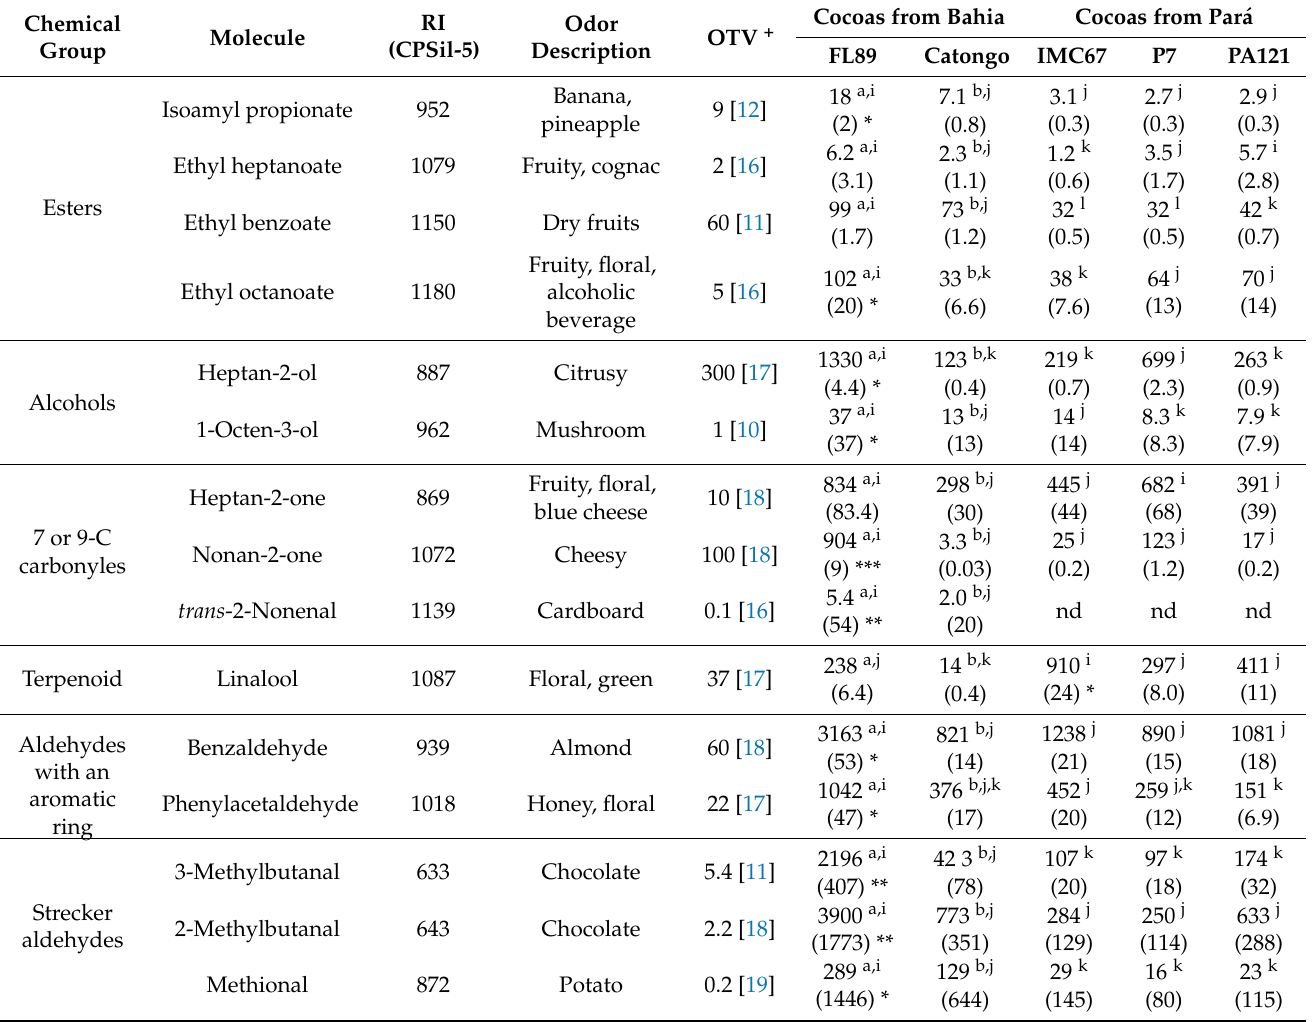
Table 2. GC-EIMS quantification of volatile aroma compounds characteristic of FL89. Concentrations given in µ g/kg and followed by Odor Activity Values (OAV) in